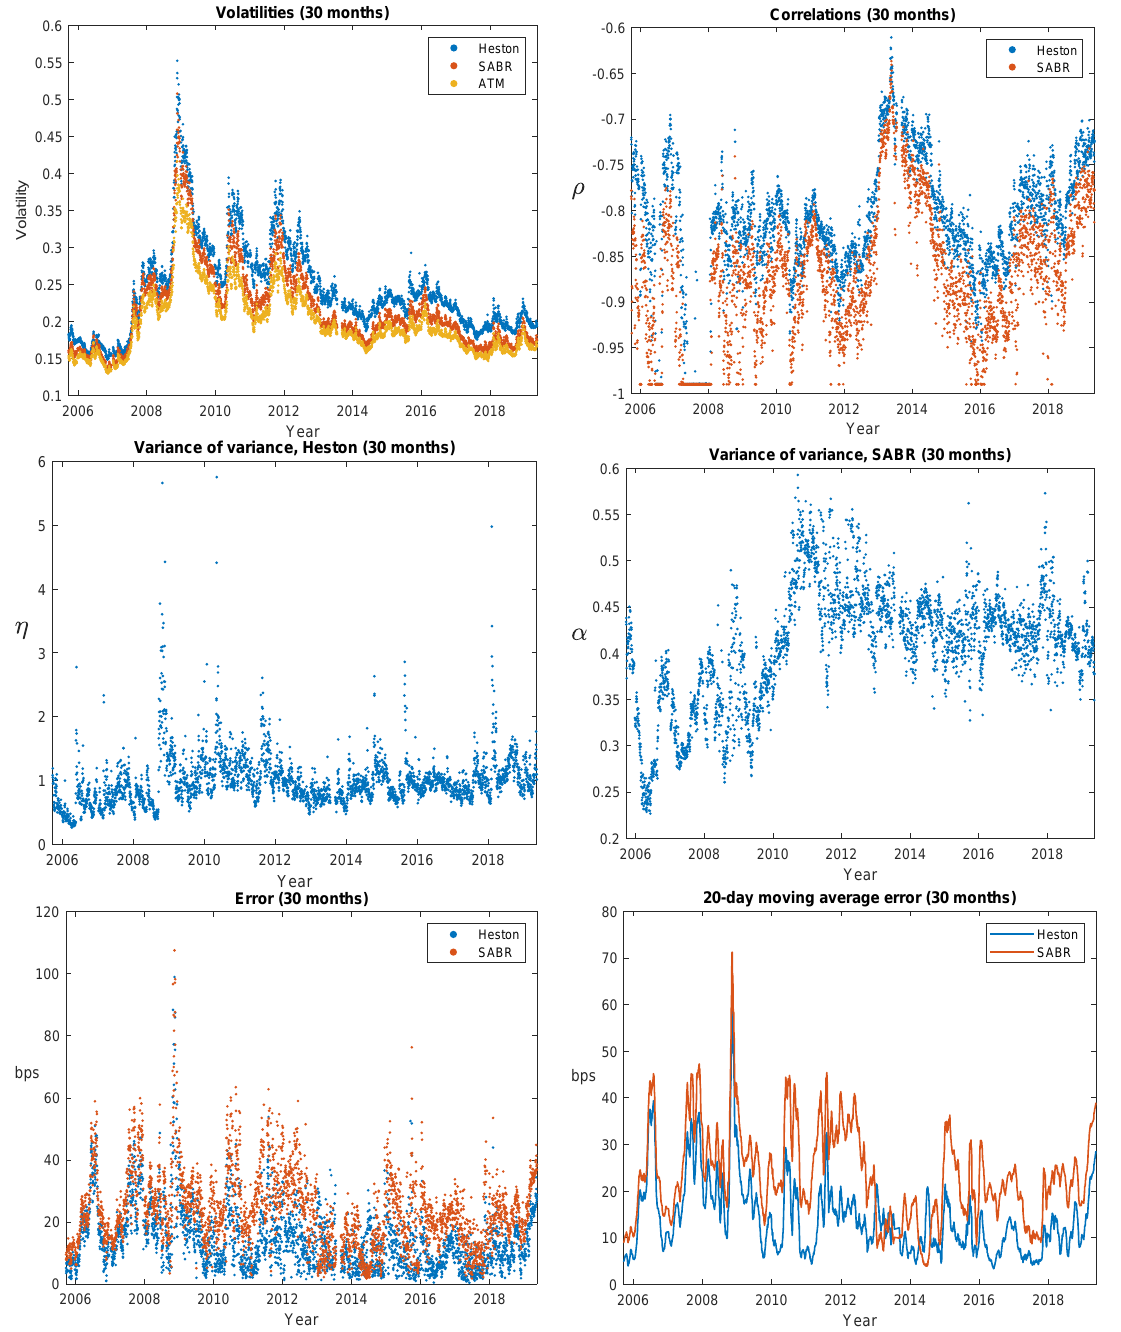
Figure 5. Calibration to the 30 months (2.5 years)